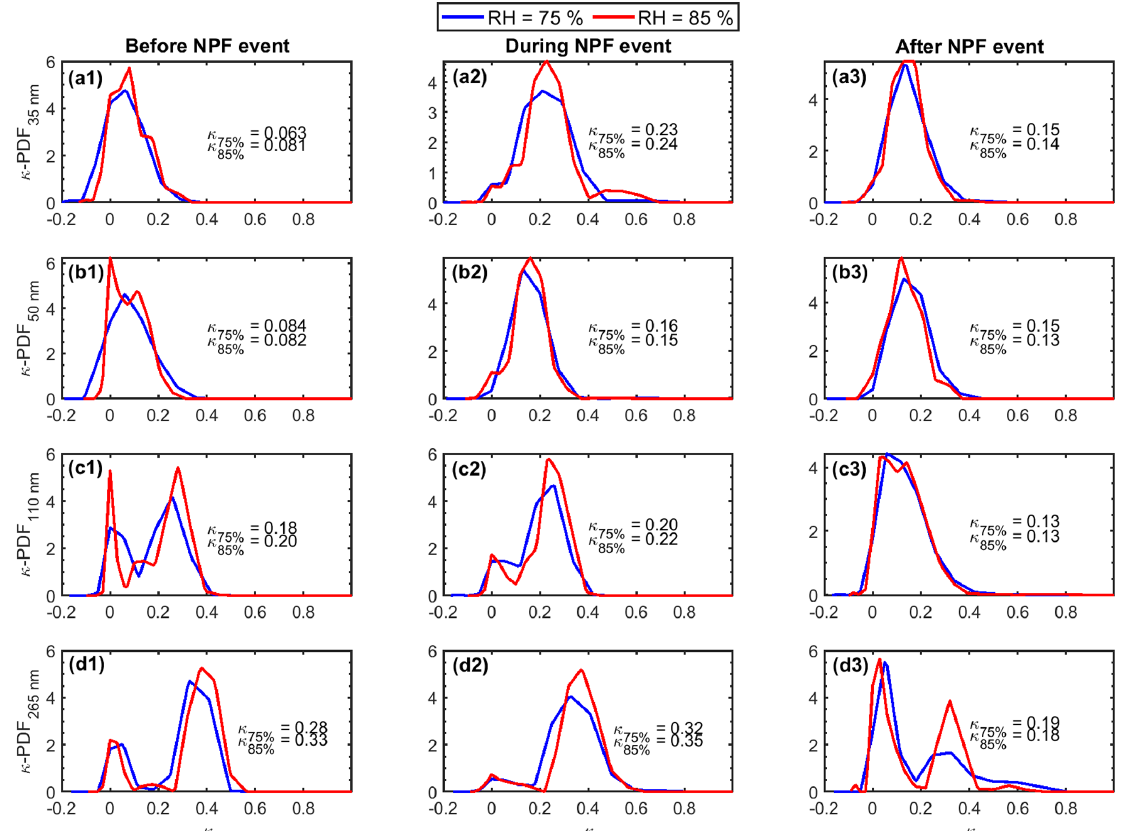
Figure 6. Probability density function of hygroscopicity parameter ( κ -PDF) before (a1–d1) , during (a2–d2) and after (a3–d3) the NPF event period (06:53, 09:57, and 23:53LT, respectively) on 2 March 2021. The mean κ value derived from each κ -PDF is also given in the